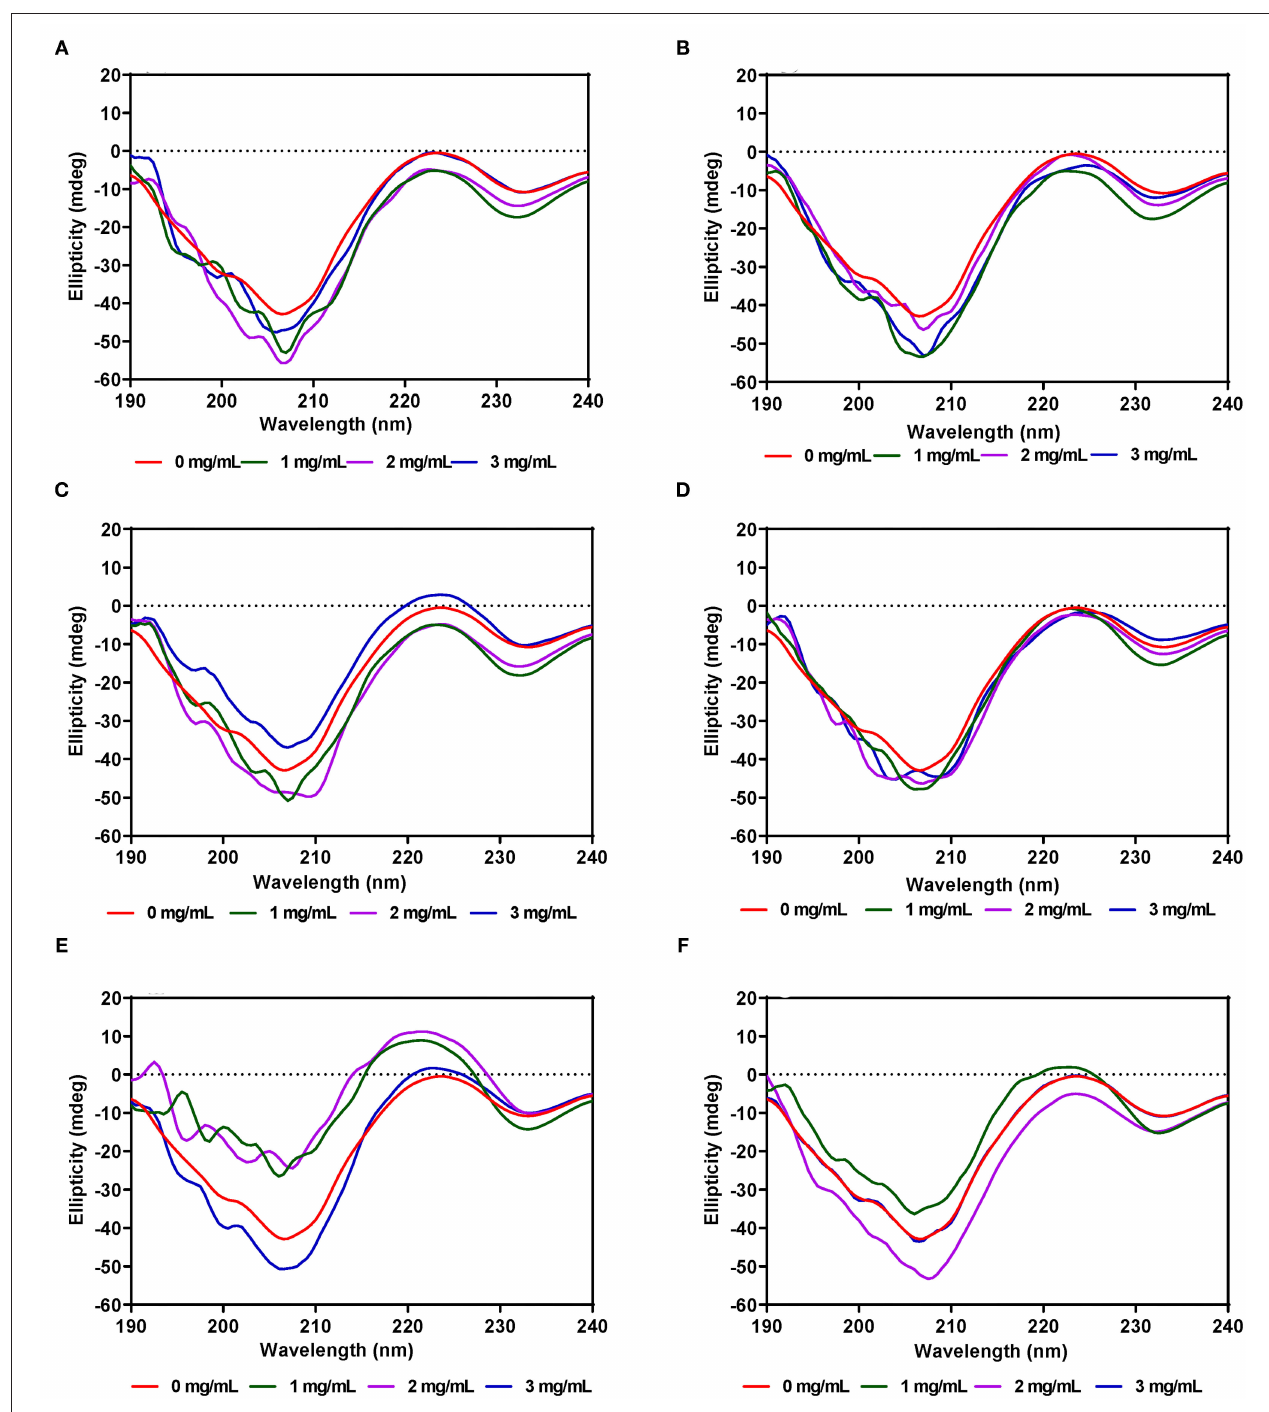
FIGURE 6 | Far-UV CD of pancreatic lipase in the presence of varied concentrations of leaf extracts from: (A) AV-40-T1, (B) AV-40-T2, (C) SM-40-T1, (D) SM-40-T2, (E) TO-40-T1, and (F) TO-40-T2. Plants were produced with nitrogen fertilizer (40 kg/ha), which was applied at (T1) or after (T2) planting.